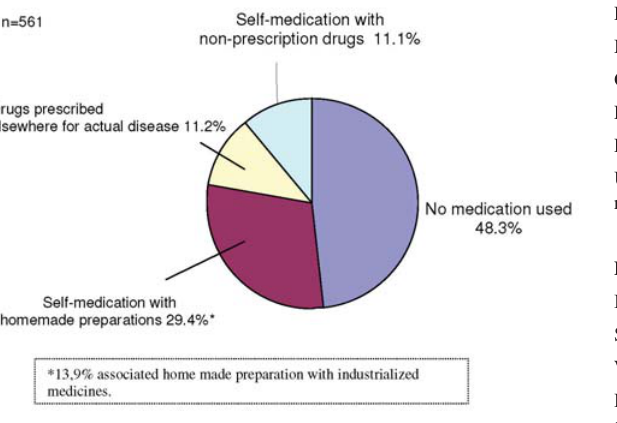
Figure 1 – Use or not self-medication before arrival at the Ophthalmology ER of University of São Paulo Medical School General Hospital, during a